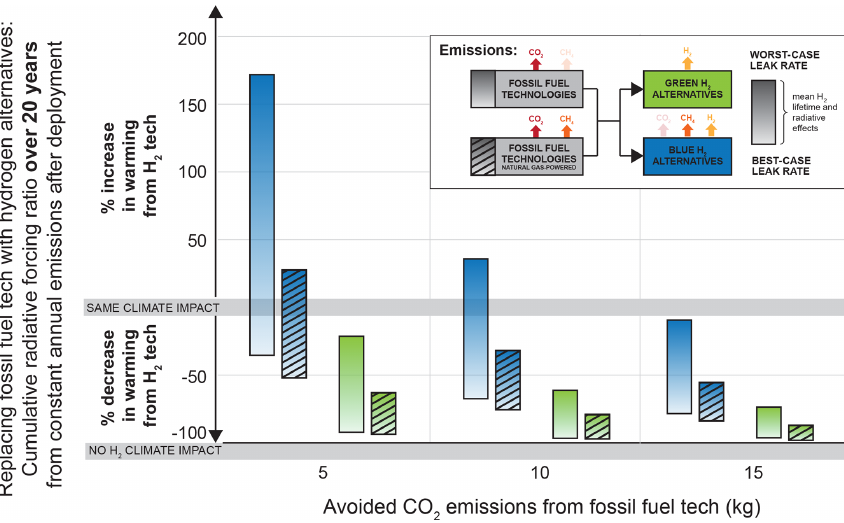
Figure 5. Relative warming impact over time from replacing fossil fuel technologies with green or blue hydrogen alternatives for different levels of avoided carbon dioxide and methane emissions. A cumulative radiative forcing ratio for annually deploying 1kg of H 2 vs. annually avoided fossil fuel emissions is used as a proxy for relative warming impacts. Emissions from hydrogen alternatives are hydrogen for green hydrogen and hydrogen and methane for blue hydrogen. Emissions from fossil fuel technologies are carbon dioxide and methane. Emissions of hydrogen and methane include a range of plausible leak rates from 1% (best case) to 10% (worst case) per unit H 2 deployed for hydrogen and from 1% (best case) to 3% (worst case) for methane. The height of each bar corresponds to the range of leakage. See Table 2 for emission inputs for hydrogen and methane from hydrogen applications, Table 4 for emissions of methane from fossil fuel technologies, and Eqs. (1)–(8) and Table 1 for the equations used in the calculation and the input parameters,